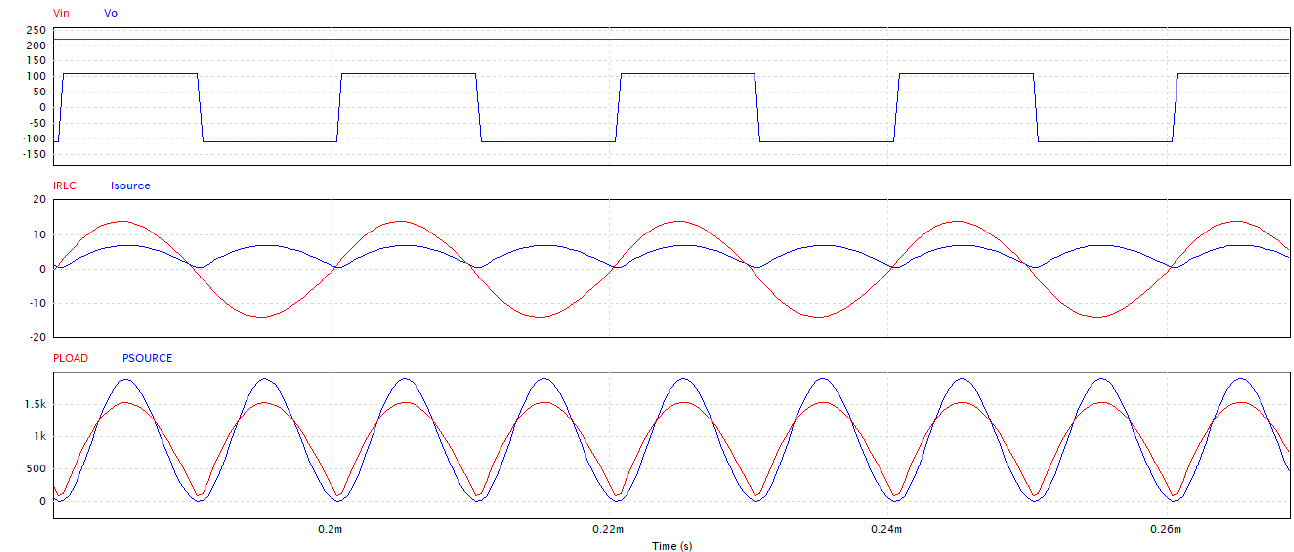
Figure 14. Power and voltage waveforms (input and output) for non-ferrous heating mode during simulation.